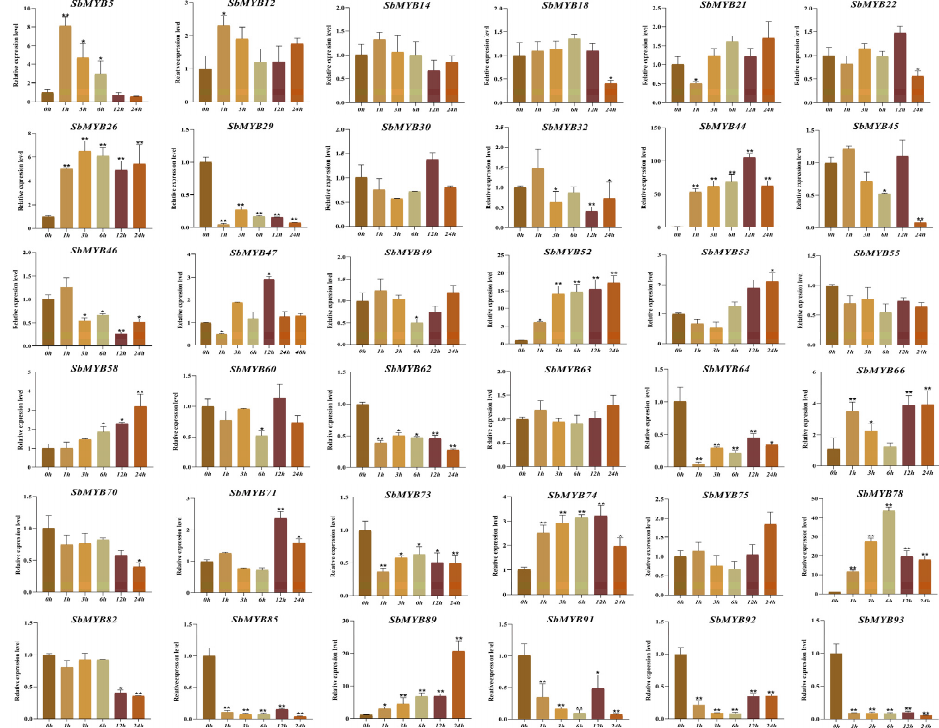
Figure 11. Response to low temperature treatments of 36 selected R2R3-SbMYB genes. The reference gene was SbACT7. Comparing the experimental and control groups (0 h), statistically significant differences are indicated by * p < 0.05, ** p < 0.01.